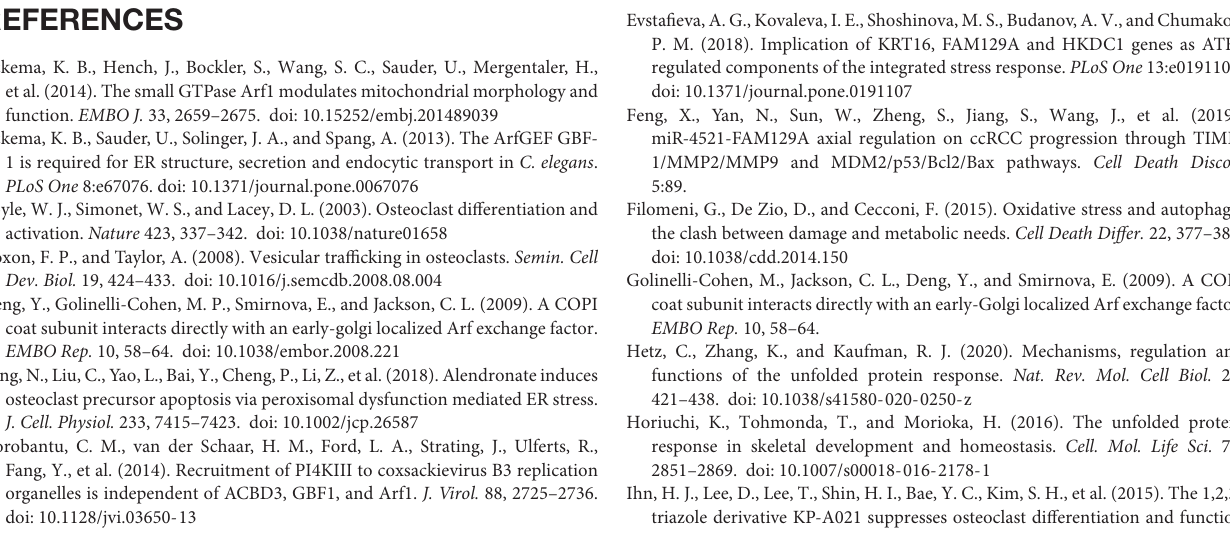
Supplementary Figure 1 | The influence of GCA on GBF1 expression. (A) Relative mRNA expression of GBF1 was examined at different stages of osteoclasts differentiation. The undifferentiated group (day 0) was used as a control group. (B) Western blot analysis of GBF1 in osteoclasts treated with 2 µ M GCA at different time points (0, 6, 10, and 14 h). (C) Immunostaining of actin rings, GBF1 antibody and nuclei in osteoclasts treated with 2 µ M of GCA for 1–2 days (original magnification, × 20). Data are expressed as mean ± SD of three independent experiments. ∗ , p < 0.05; ∗∗ , p < 0.01; ∗∗∗ , p < 0.001. Supplementary Table 1 | PCR primer list for quantitative real-time